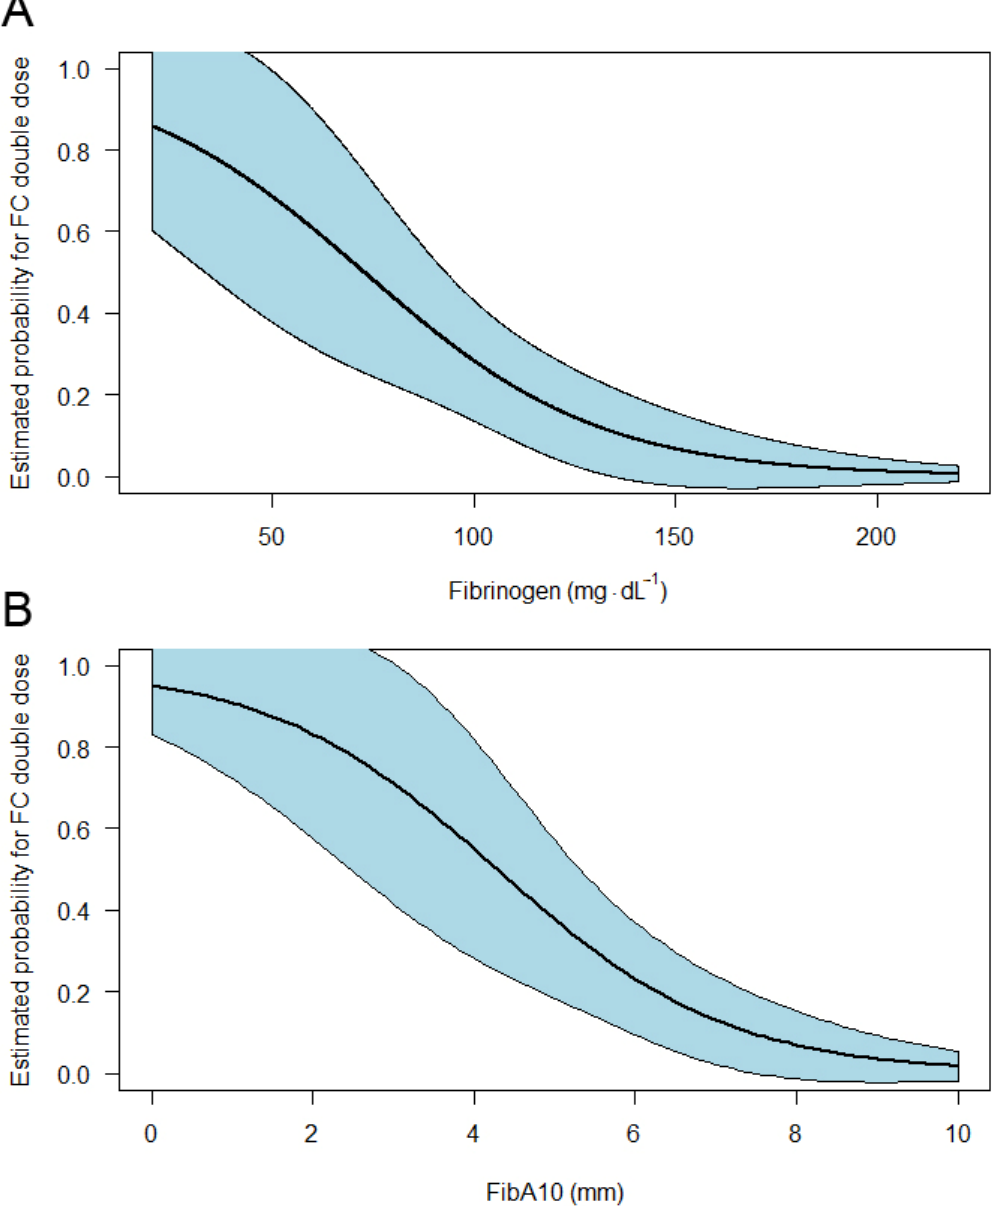
Figure 2. Estimated probability for the need of double dose fibrinogen concentrate administration in dependency of initial fibrinogen levels ( A ) and fibrin polymerization (FibA10, B ).